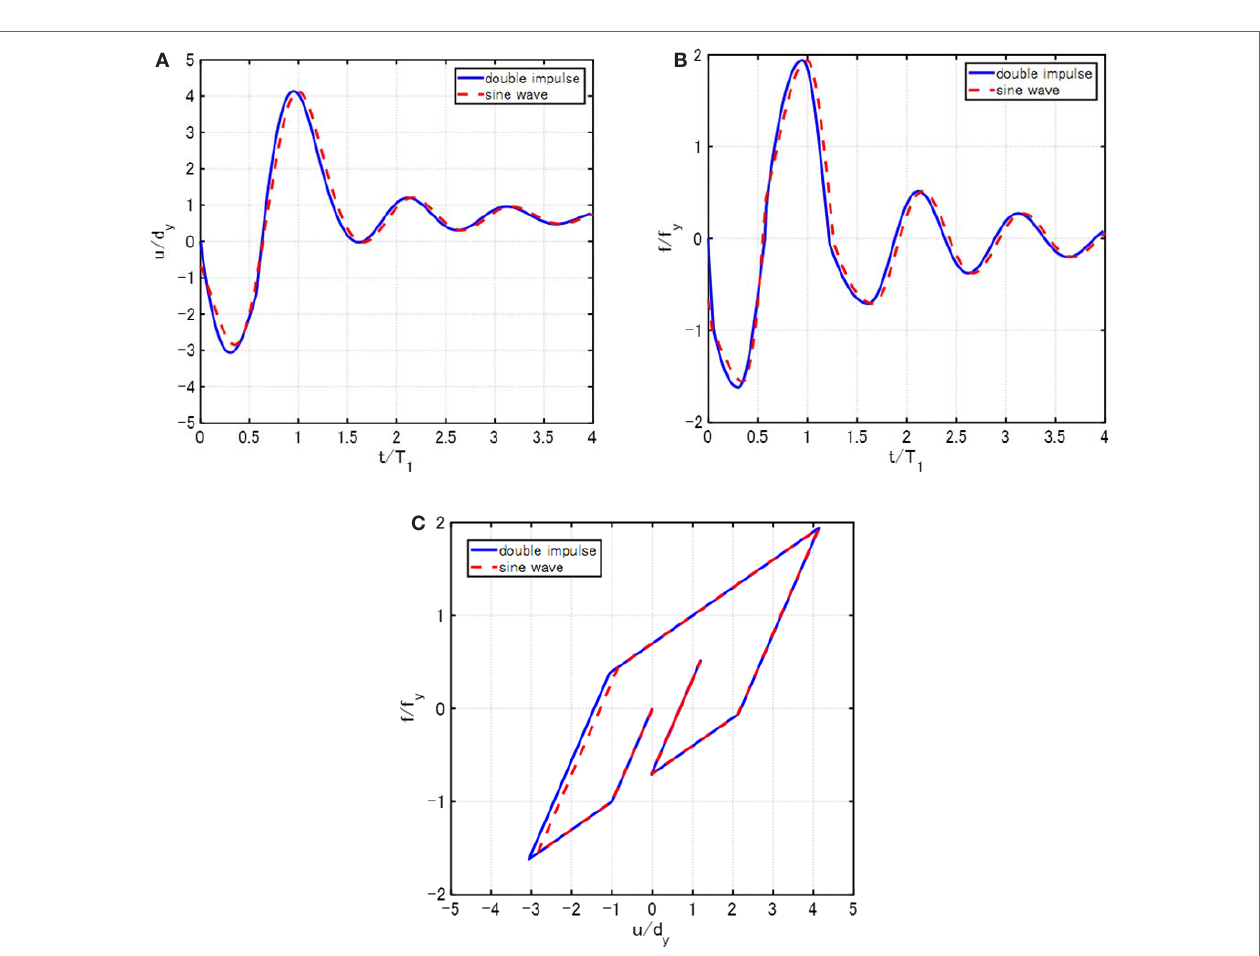
Frontiers in Built Environment |